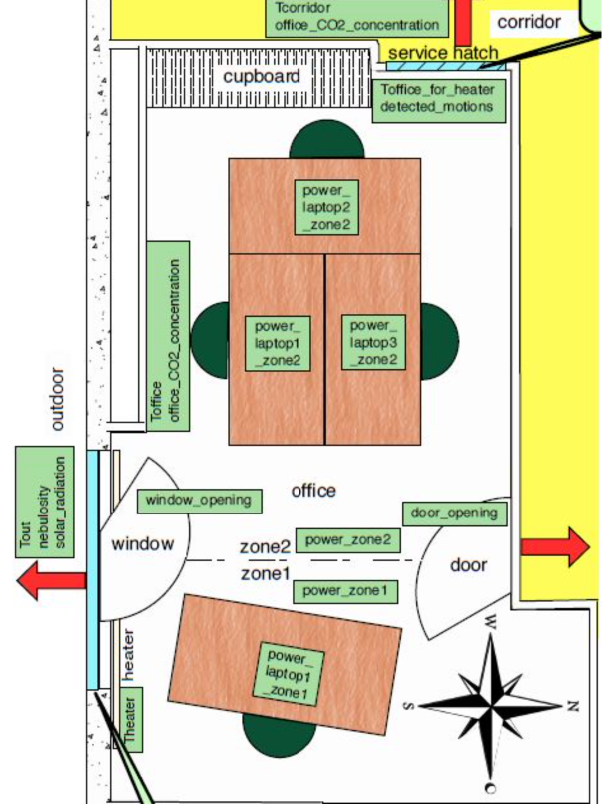
Figure 2. Office in Ense3, Grenoble Institute of Technology,